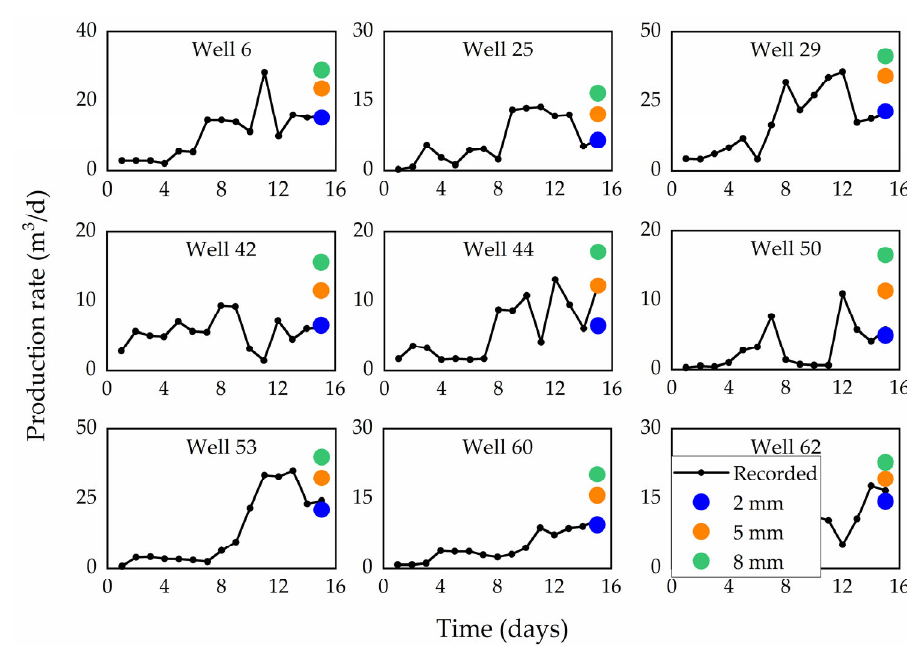
Figure 12. E ff ect of the SI on production Figure 12. Effect of the SI on production rate. Figure 12. Effect of the SI on production rate.